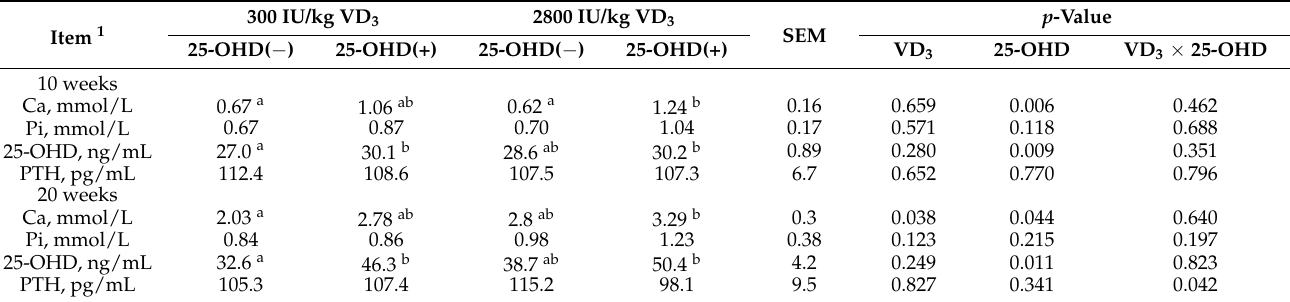
Table 5. Effects of dietary VD 3 level and 25-OHD on serum parameters.